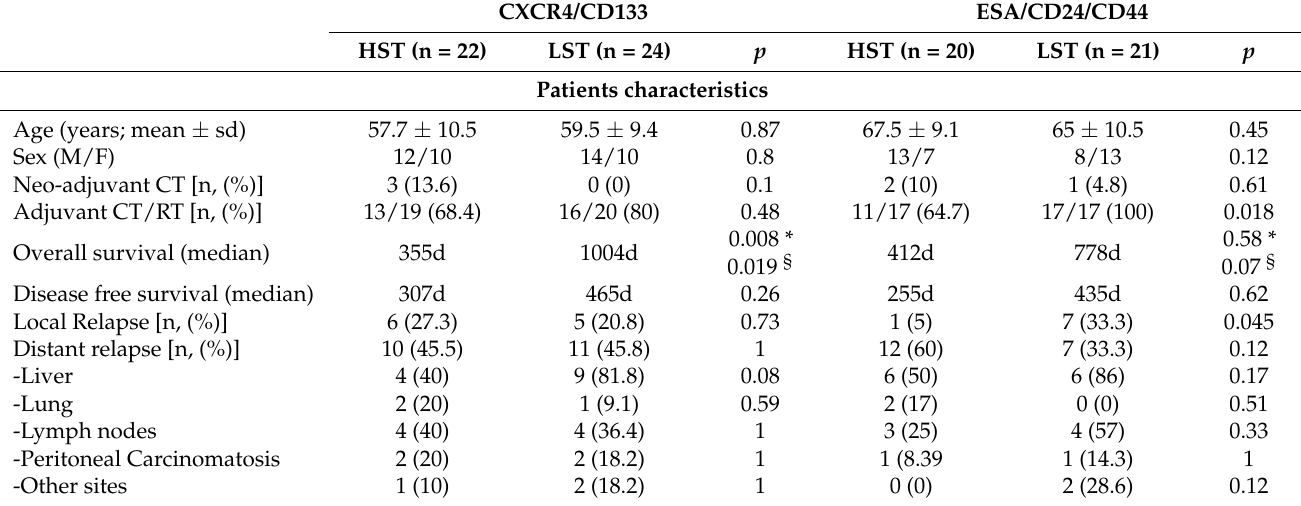
Table 2. Patients and tumor characteristics according to tumor